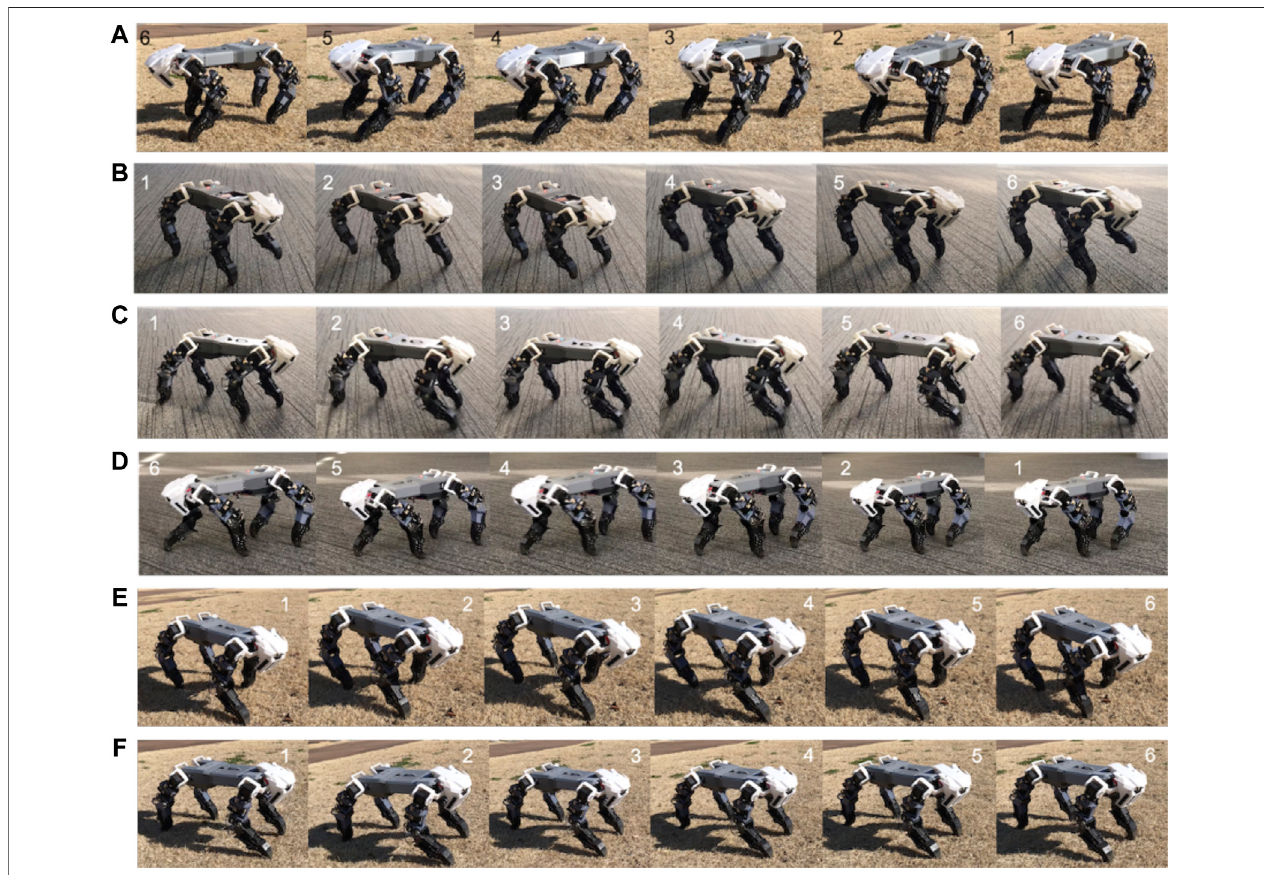
FIGURE11| Therobot ’ sdynamicgaitpattern (A) onnaturalterrain (B) on fl at terrain. (C) Dynamic gaitpatternon fl at terrainwithinjuredforelimb. (D) On fl atterrain with injured hindlimb. (E) On natural terrain with injured forelimb. (F) On natural terrain with injured hindlimb. The video of robot ’ s performance can be seen in the link of Video 2